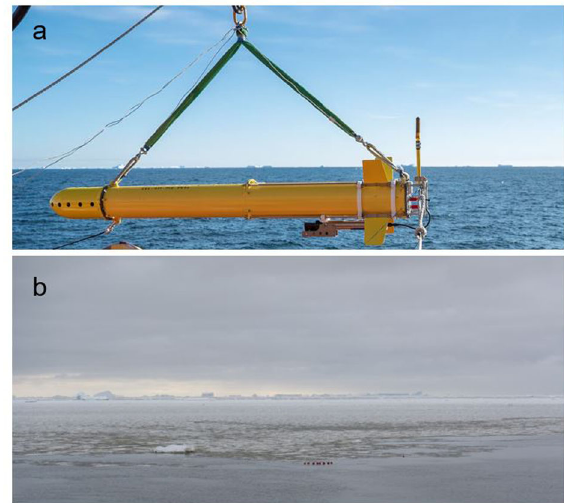
Fig. 2 Oceanic states at Cape Darnley Polynya and the deployed tethered Ocean Observing System-1 pro fi ler. a Oceanic state on 26 February 2017 during warm summer and b on 26 February 2018 of normal summer.